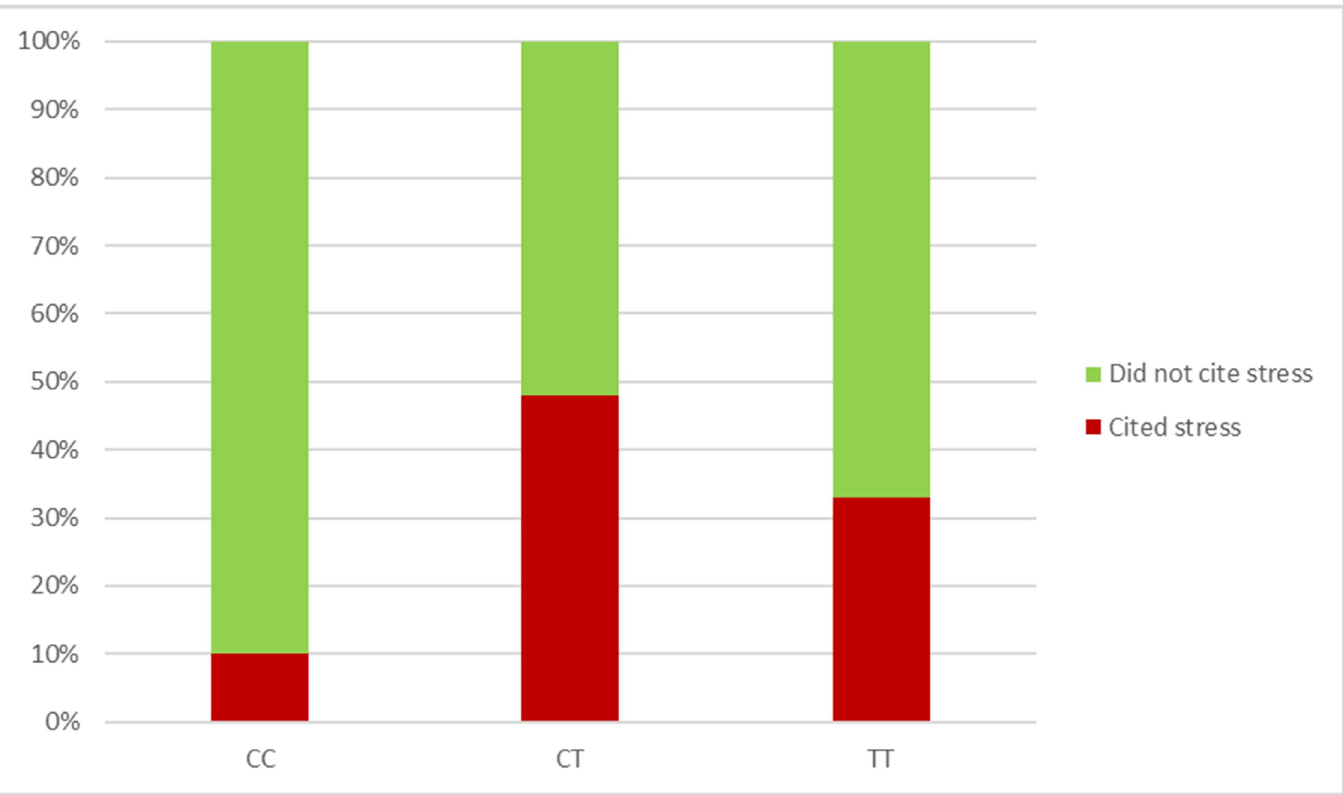
Fig 2. Genotype by stress as a pain